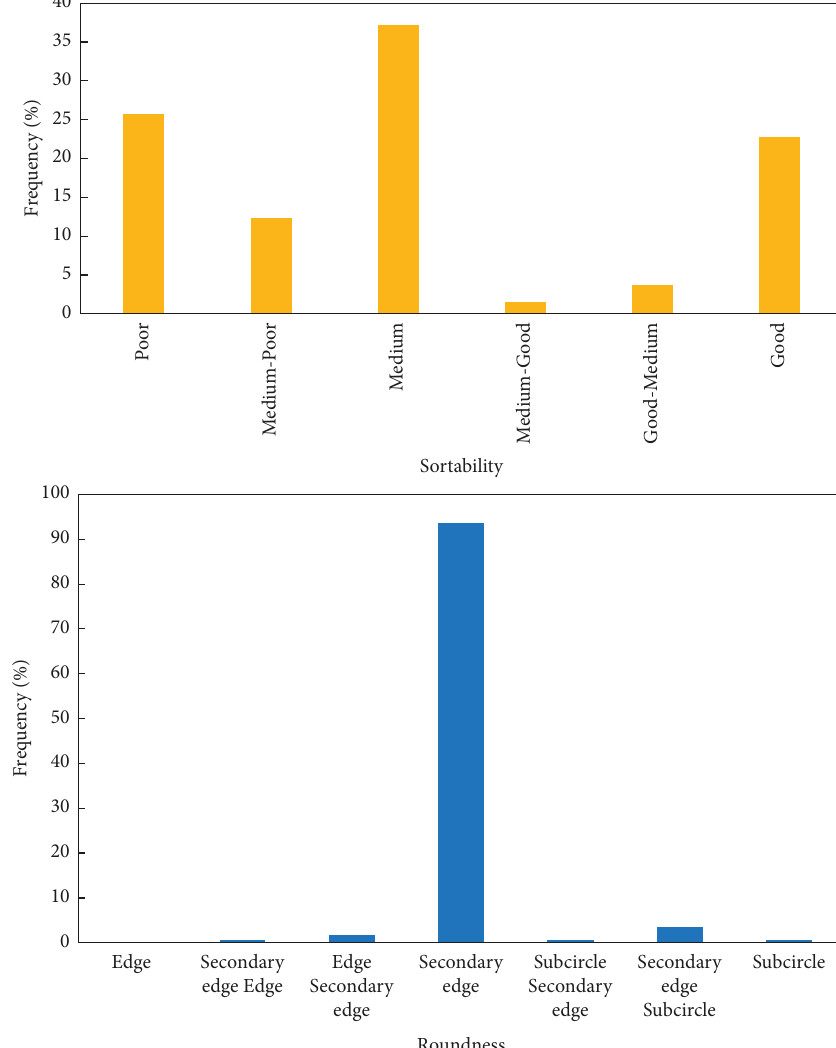
Figure 6: Histogram of clastic particle sorting and roundness distribution of sandstone in long 6